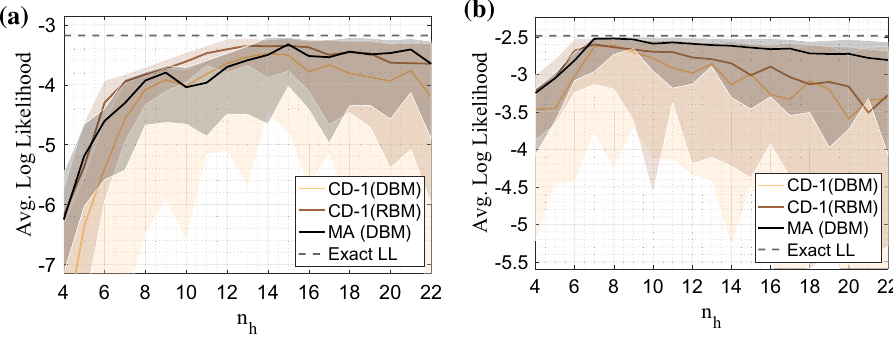
Figure 2. Average converged log-likelihood performance (lower bound) between RBMs trained with CD-1, mode-assisted DBMs (MA), and unassisted DBMs with CD-1. The DBMs have two hidden layers. The networks were trained on the shifting bar data set with n v = 24 (left plot) and n v = 12 (right plot) for 200,000 and 100,000 gradient updates respectively, following a linearly decaying learning rate schedule from ǫ = 1 → 0.001 . For the DBMs the hidden layer ratio was fixed at α = n h ( 2 ) / n h ( 1 ) = 0.2 . Performance is shown as a function of total number of hidden nodes, n h = n h ( 1 ) + n h ( 2 ) . The solid lines are the median obtained across an ensemble of 50 networks, and the shaded regions enclose the 95th and 5th